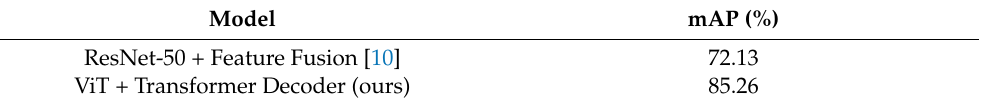
Table 5. Comparison results of our model and the modified model of research [10] on our dataset. Model mAP (%) ResNet-50 + Feature Fusion